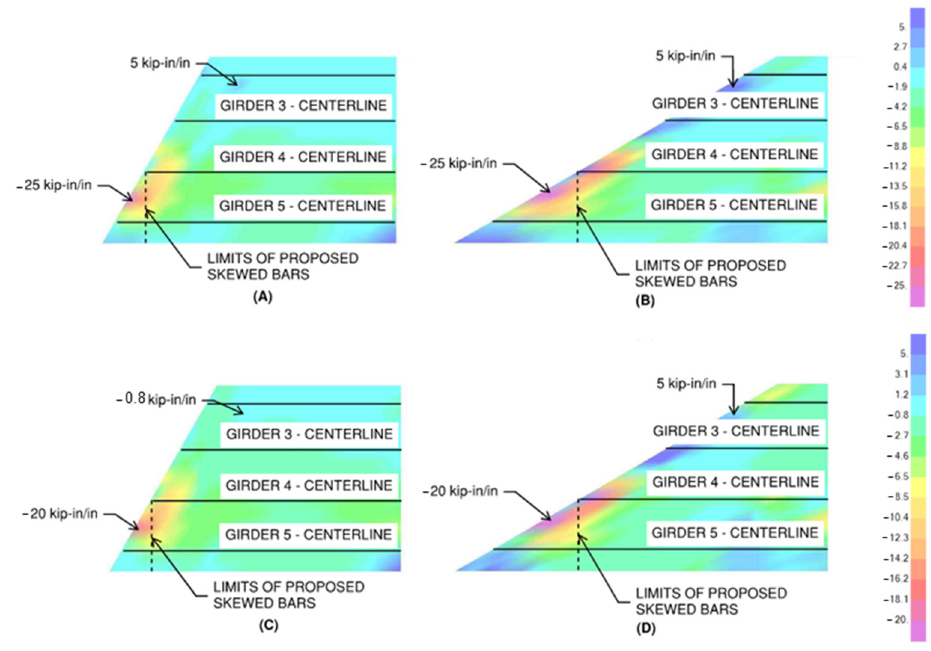
Figure 17. The moment distribution (k-in/in) in the top transverse reinforcement under ( A ) Design Case 2 with 45 degree skew, ( B ) Design Case 2 with 60 degree skew, ( C ) Design Case 3 with 45 degree skew, and ( D ) Design Case 3 with 60 degree skew.